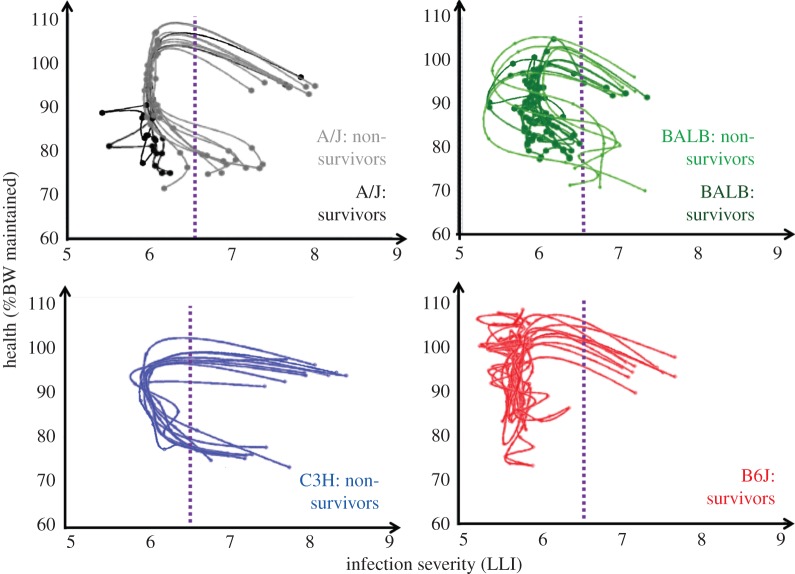
Spaghetti plots of individual trajectories of each mouse strain. The purple line shows the infection severity threshold that discriminates between survivors and non-survivors, independent of mouse inbred strain. All non-survivors except for one A/J mouse had crossed this threshold after 1 dpi, whereas none of the survivors had crossed this threshold after 1 dpi.